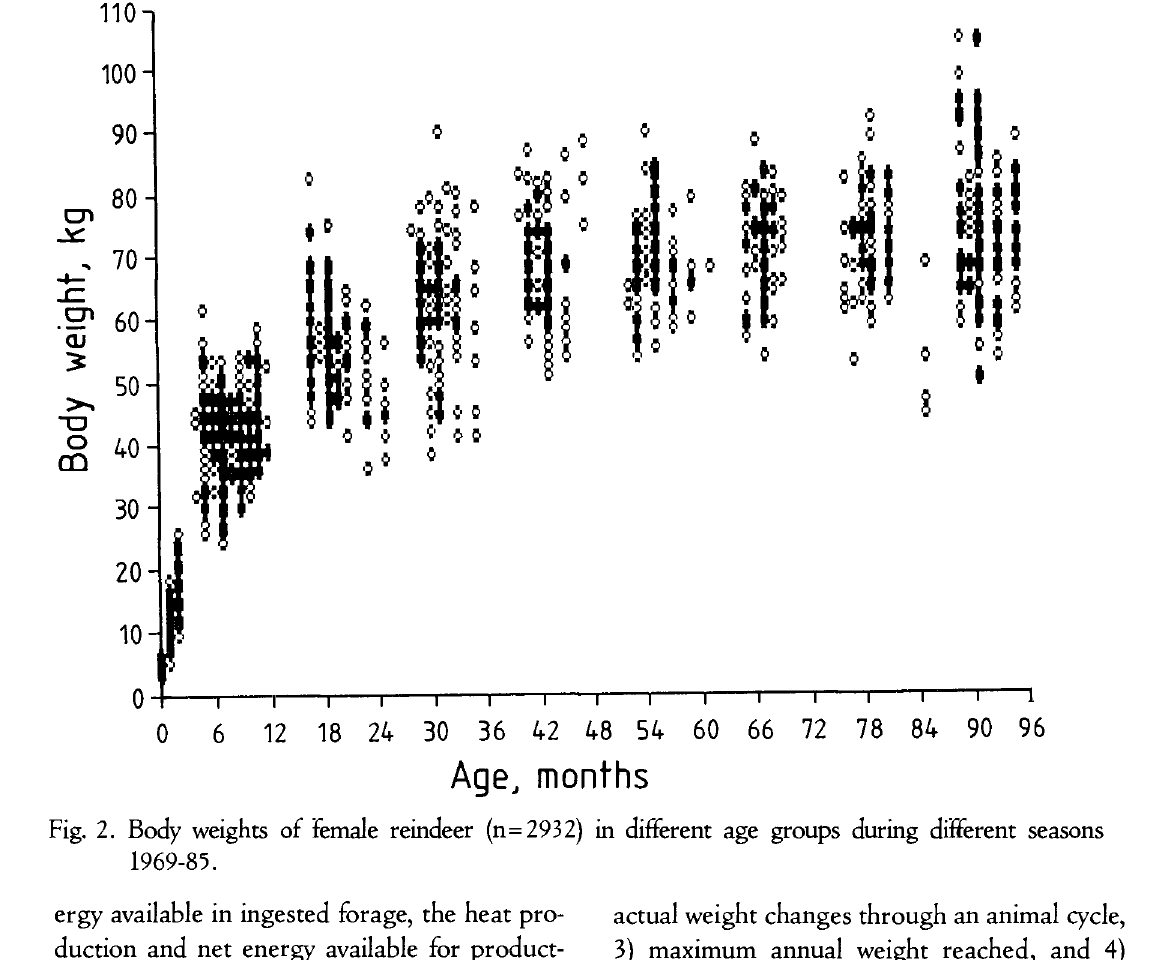
Fig. 2. Body weights of female reindeer (n=2932) in different age groups during different seasons